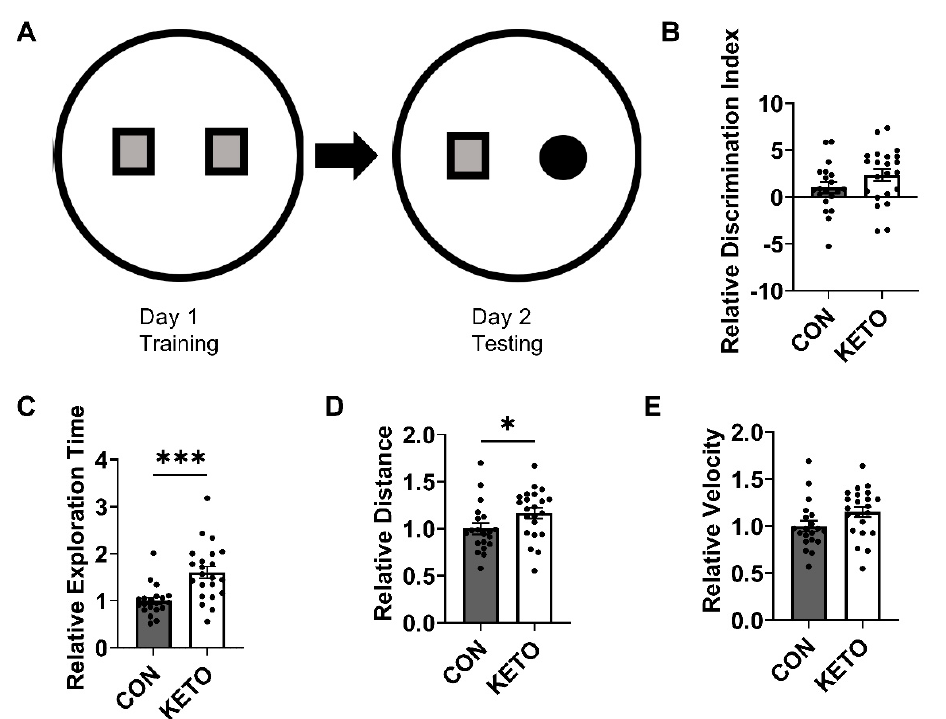
Figure 2. Ketogenic diet enhances novel object recognition and locomotion. ( A ) Two-object novel object recognition test layout and resulting measures of recognition memory (( B ) discrimination index and ( C ) exploration time) and locomotion (( D ) distance and ( E ) velocity). CON n = 20; KETO n = 22. * p < 0.05, *** p < 0.001.